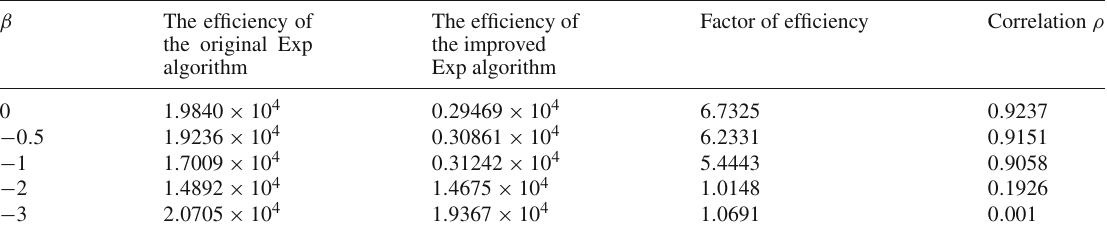
Table 5 The efficiency of simulation algorithms as (simulated variance × CPU time) for the down-and-out call barrier option under CEV model with M = 10 6 , σ = 0 . 25 and (cid:7) t = E [ δ t ] = 0 . 002 β The efficiency of the original Exp algorithm